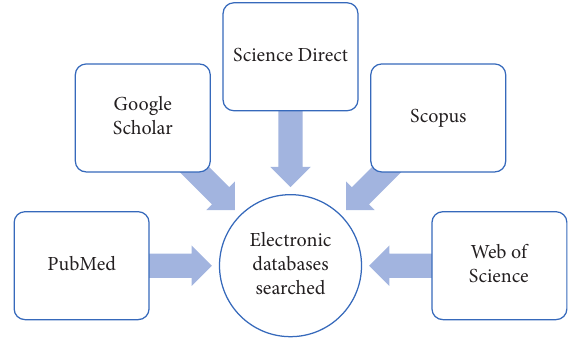
Figure 1: Five electronic databases searched for this